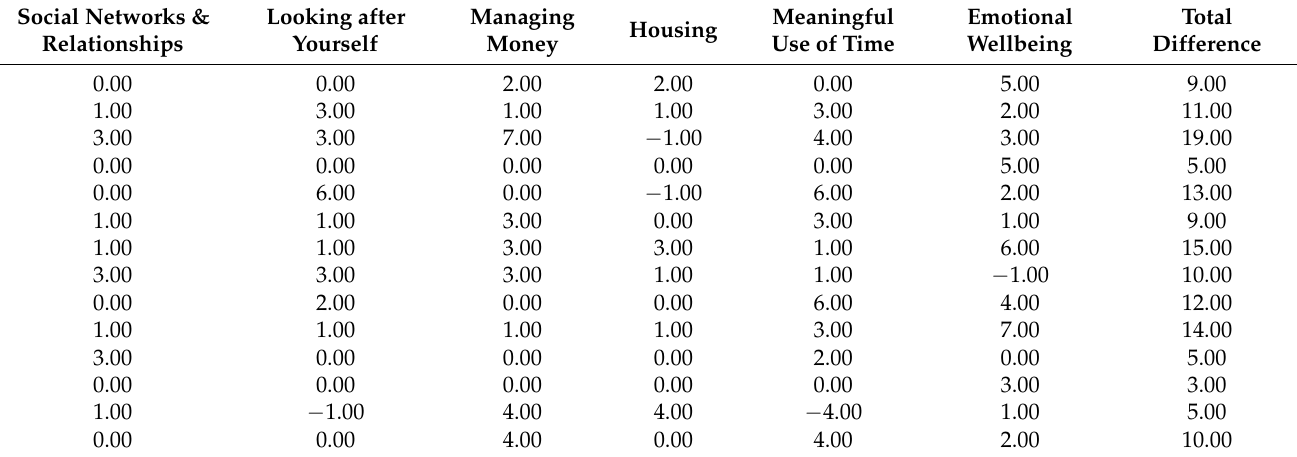
Table 4. Differences between scores on the Wellbeing Wheel upon entry and exit to the